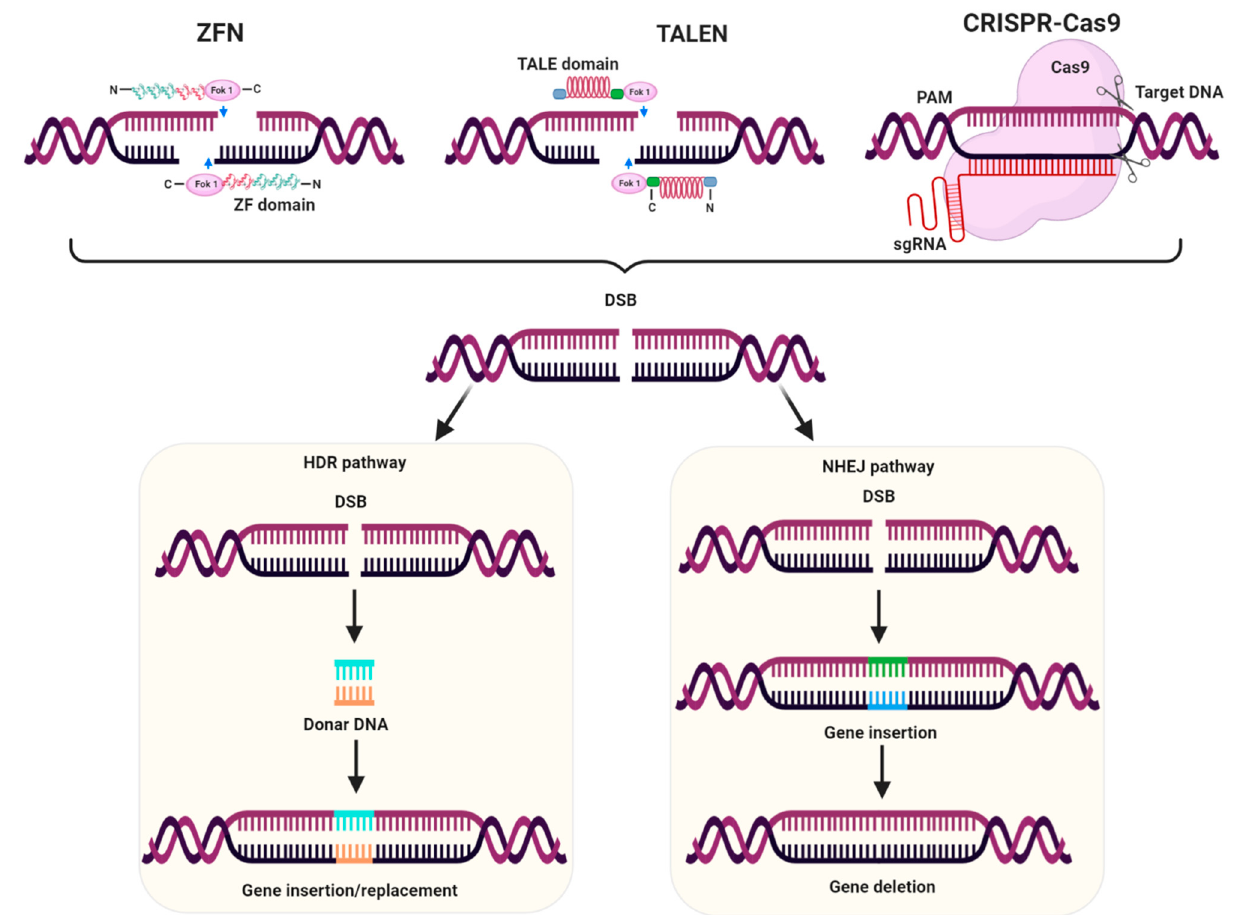
Figure 1. Mechanism of genome editing tools. These genome editing tools employ sequence-specific nucleases to recognize a particular DNA target sequences to generate double stranded breaks (DSBs). zinc finger nucleases (ZFNs) are targetable DNA cleaving proteins applied to cleave DNA sequences at any site. TALENs trigger DSBs at target site that induces DNA damage response pathways, leading to genome modification. CRISPR-Cas9 is an RNA-guided endonuclease directed by guide RNA (gRNA), and it binds at the target site adjacent to the protospacer adjacent motif (PAM) and creates a DSB. To repair the DSBs, two repair mechanisms are used by the cell: non-homologous end joining (NHEJ), which creates indels leading to a loss-of-function mutation, and homology-directed repair (HDR), which involves the introduction of a template DNA to repair DSBs that results in the correction of pre-existing